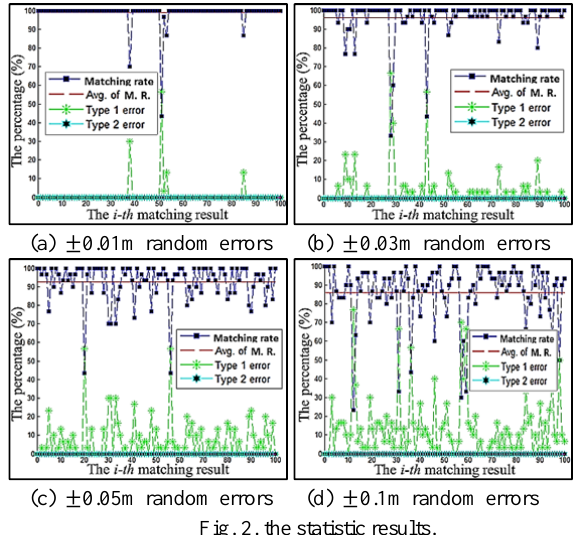
Fig. 2. the statistic results.